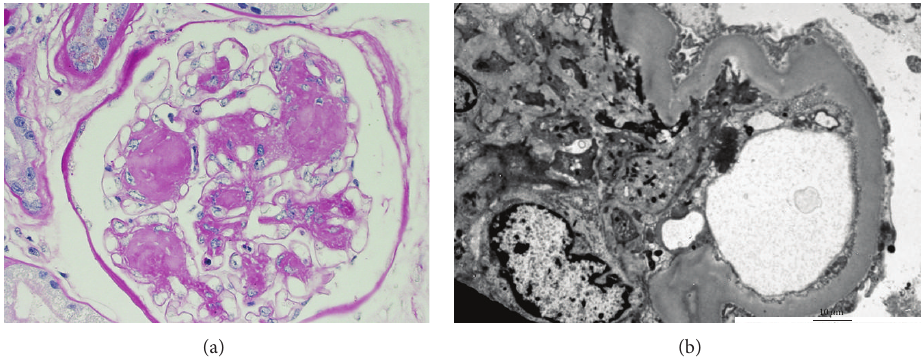
Figure 1: (a) Light microscopy with hematoxylin-eosin staining reveals extensive mesangial expansion without marked increase in cellularity. A Kimmelstiel-Wilson (KW) lesion is shown here and refers to the nodular glomerulosclerosis that can be seen in late disease but is not as common as diffuse diabetic glomerulosclerosis. KW lesions are usually spherical and eosinophilic and have a central hypocellular or acellular area. Mesangial expansion and KW lesions are both due to increased extracellular matrix production. (b) Electron microscopy reveals a thickened basement membrane and podocyte foot process